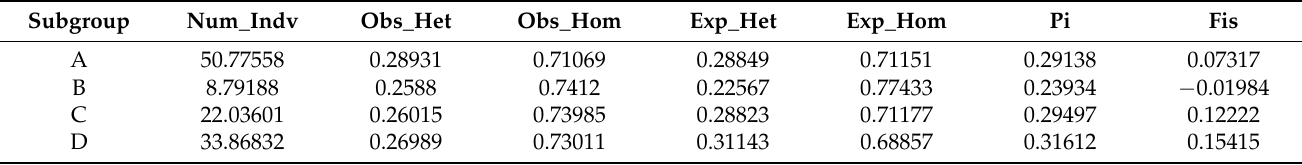
Table 3. Analysis of population genetic diversity.